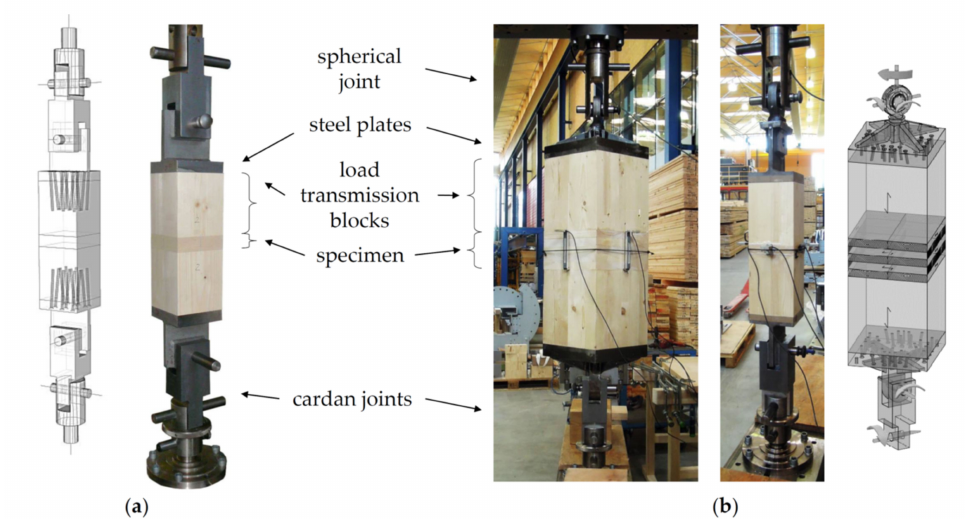
Figure 5. ( a ) test setup with cardan joints on both ends as used by Stuefer [39]; ( b ) test setup as used in Jantscher [37], exemplarily shown for the series 1s and series 5sCL300 2 with a cardan joint at the bottom and a spherical joint at the